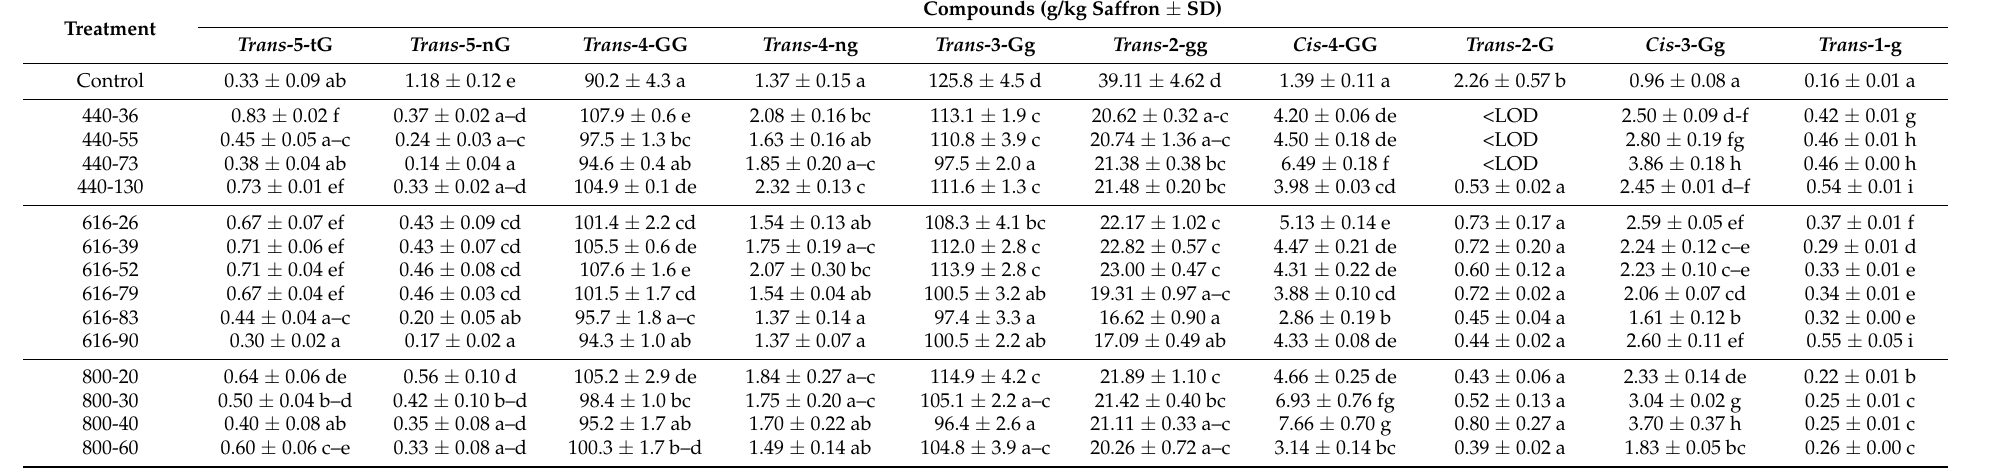
Table 3. : Crocetin esters content of saffron obtained by different dehydration